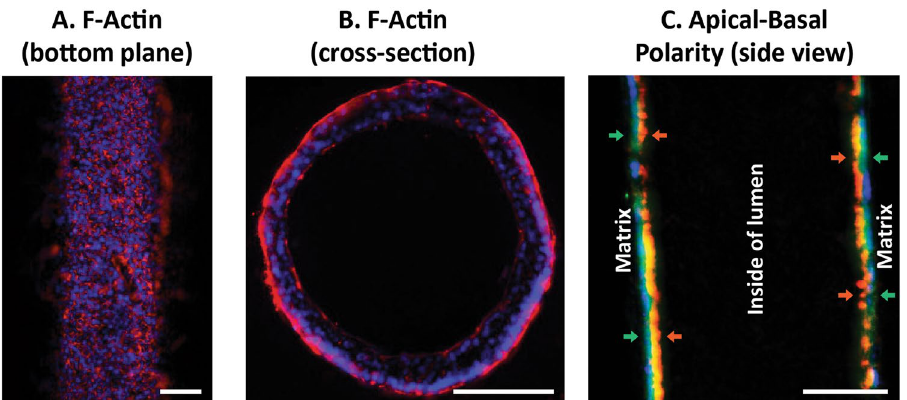
Figure 2. MCF7s form confluent polarized ductal structures. The ( A ) bottom plane and ( B ) cross-section of MCF7- derived lumens stained with F-Actin (red) and nuclei (blue) were imaged. ( C ) To evaluate apical-basal polarity, samples were stained for nuclei (blue), laminin-5 (green; basal), and golgi (red; apical). Scale bars represent 100 μ